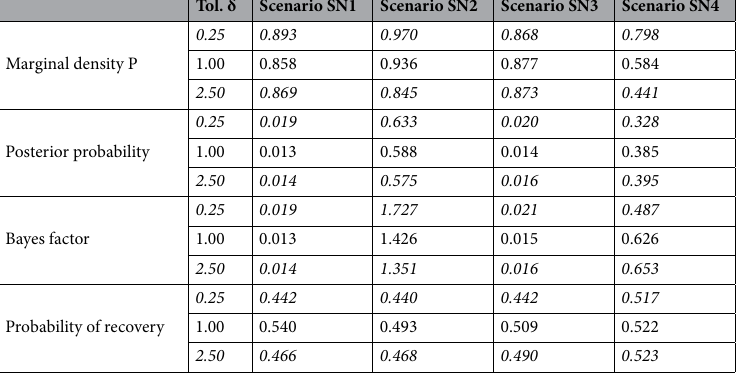
Table 2. Model choice results. Marginal densities, posterior probabilities, Bayes factors (Model i against the others) and probability of recovery for each simulated scenario with a tolerance level of 1% (0.25% and 2.5% in